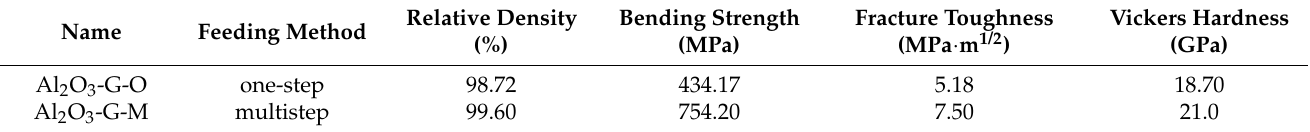
Table 1. The relative density and mechanical properties of Al 2 O 3 -G-O and Al 2 O 3 -G-M prepared by the two feeding methods.